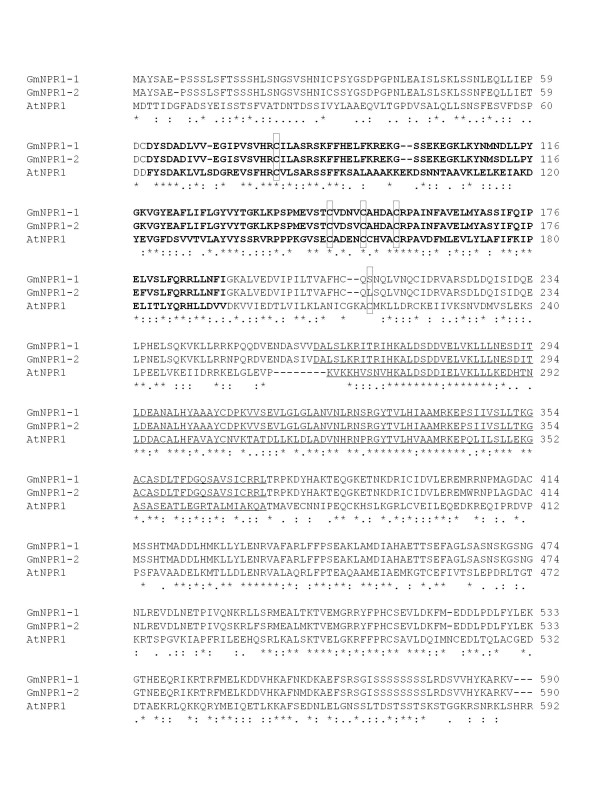
Comparison of GmNPR1-1 and GmNPR1-2 sequences with that of Arabidopsis NPR1. Broad-complex Tramtrack Bric-a-brac/Poxvirus and Zinc finger domain (BOB/POZ) is represented by bold letters and Ankyrin repeat domain (ANK) is underlined. Five Arabidopsis cysteine residues (Cys82, Cys150, Cys156, Cys160 and Cys216) regulating NPR1 functions are marked with rectangular boxes. "*" represents identical residues; ":" means conserved substitutions between similar residues; "." indicates the semi-conserved substitutions between similar residues.